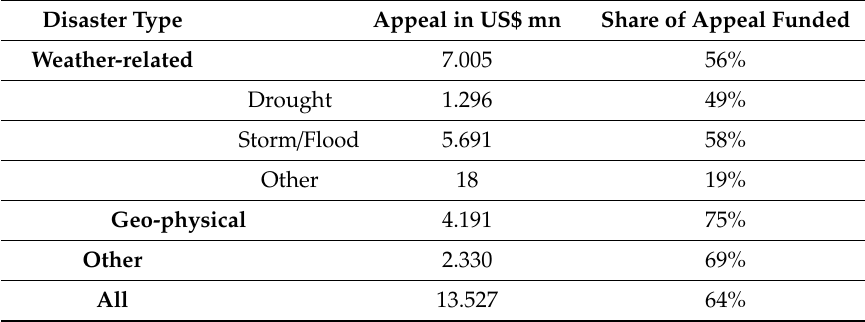
Table 2. UN emergency assistance appeals and funding by disaster type,